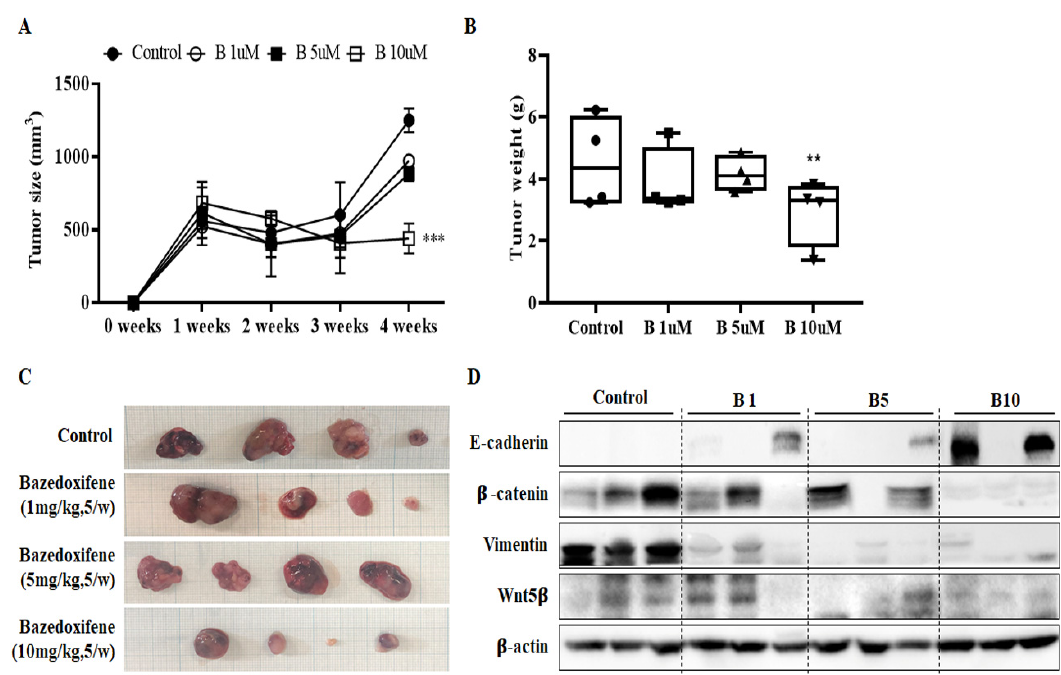
Figure 6. Bazedoxifene inhibited SiHa tumor growth in vivo. SiHa cells (1 × 10 7 ) were injected subcutaneously into Balb/c nude mice with an equal volume of PBS. When tumors had grown to 150 mm 3 , mice were administered vehicle or 1, 5, or 10 mg/kg Bazedoxifene daily by oral gavage. ( A ) Tumor volumes were calculated from caliper measurements. ( B ) After 14 days of treatment, all mice were sacrificed, and the total mass of each tumor was determined at autopsy ( n = 4 mice per treatment group). ( C ) The tumor masses were excised for comparison between groups. ( D ) The phosphorylation levels of EMT signaling proteins were determined using Western blot analysis of the harvested tumor tissue. β -actin served as a loading control (**, p < 0.01 ***, p < 0.001 vs. control). B: Bazedoxifene.